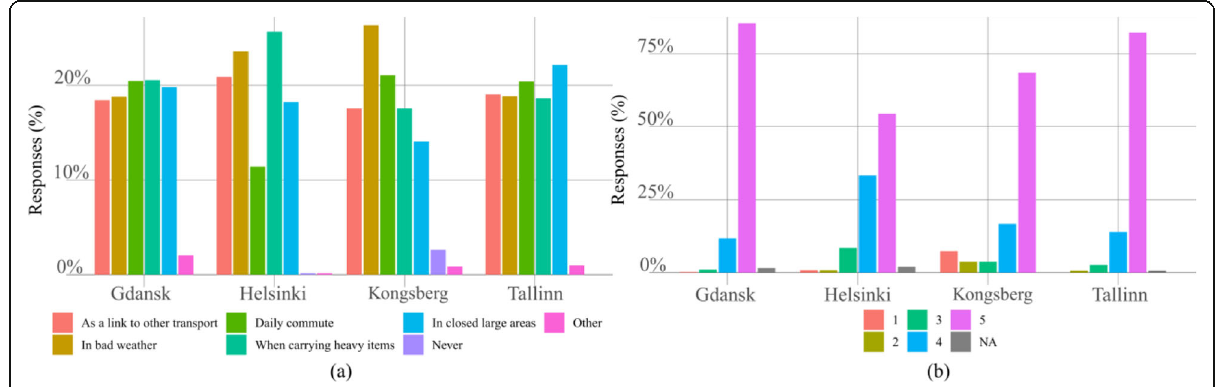
Fig. 6 Distribution of relative scores for: ( a ) use cases, and ( b ) overall experience. Questions n. 4 and 6